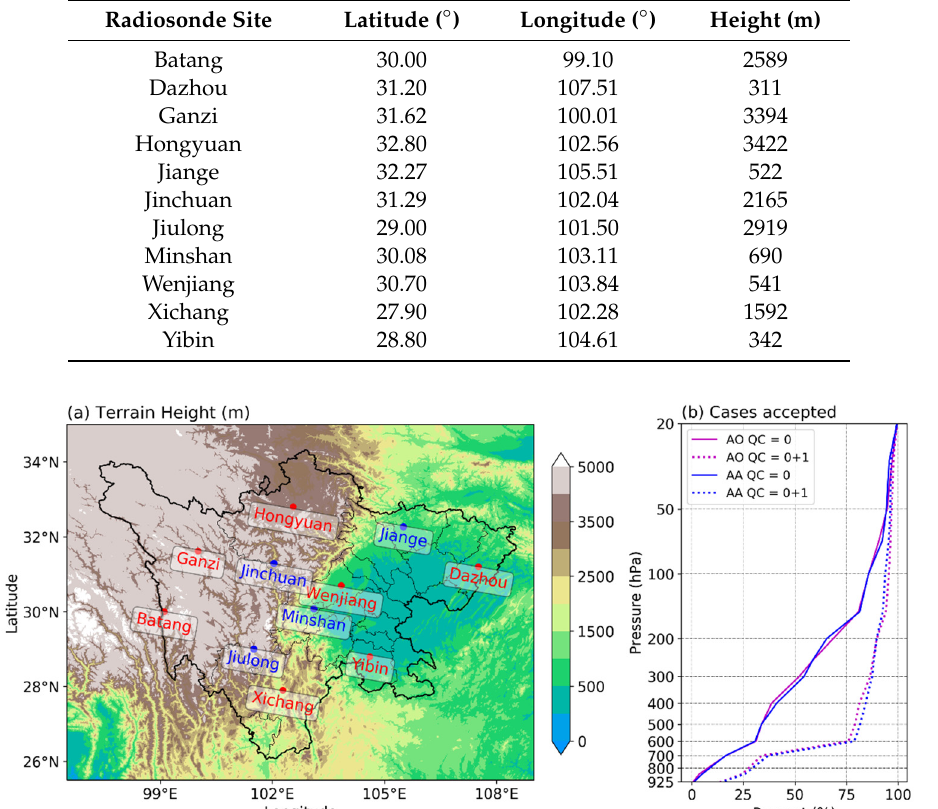
Table 1. Radiosonde sites in the lee of the Tibetan Plateau (TP).